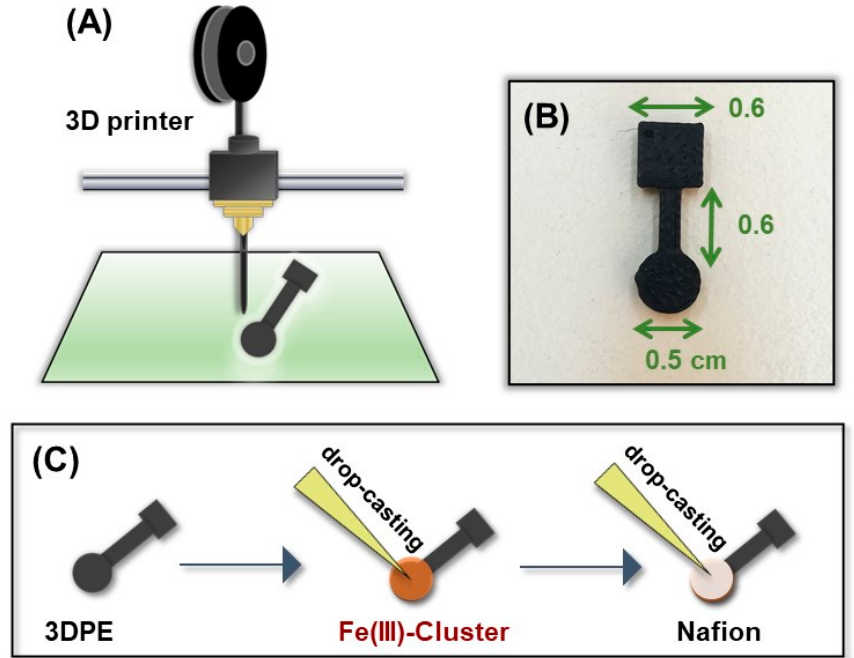
Figure 3. ( A ) Schematic illustration of the 3D printing process of the sensor. ( B ) A photograph of the 3D printed sensor and its dimensions in cm. ( C ) Schematic illustration of the drop-casting procedure for the construction of the GLU 3DPE modified with [Fe 3 O(PhCO 2 ) 6 (H 2 O) 3 ] ∙ PhCO 2 .